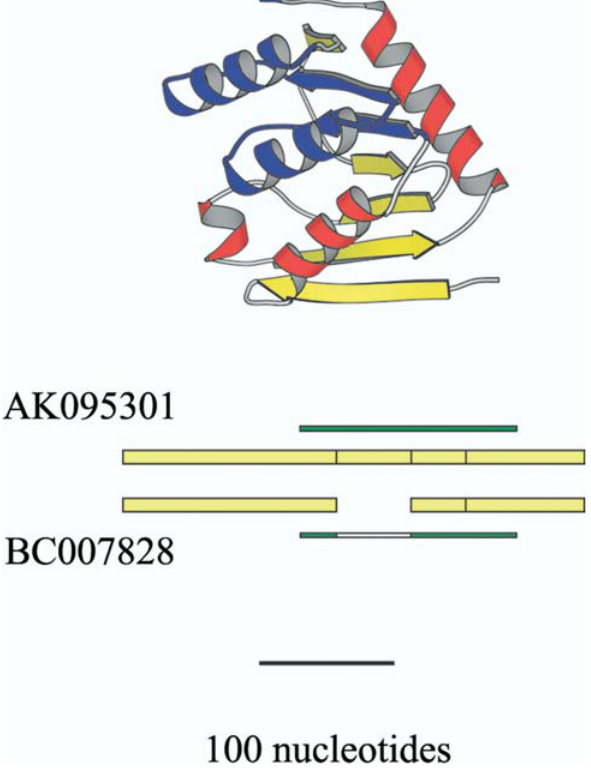
Figure 3. An Example of Different Structures Encoded by AS Variants Exons are presented from the 5 9 end, with those shared by AS variants aligned vertically. The AS variants, with accession numbers AK095301 and BC007828, are aligned to the SCOP domain d.136.1.1 and corresponding PDB structure 1byr. Helices and beta sheets are red and yellow, respectively. Green bars indicate regions aligned to the PDB structure, while open rectangles represent gaps in the align- ments. AK095301 is aligned to the entire PDB structure shown, while BC007828 is lacking the alignment to the purple segment of the structure. DOI: